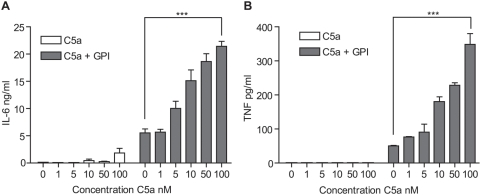
C5a potentiates pfGPI-induced inflammatory cytokines in a dose-dependent manner.Human PBMCs were stimulated with varying concentrations of recombinant human C5a (0, 1, 5, 10, 50, 100 nM) for 24 hours, with or without pfGPI. Culture supernatants were collected and assayed for IL-6 (A) and TNF (B) by ELISA. Data were analyzed by two-way ANOVA and demonstrate an interaction effect (C5a*pfGPI) for IL-6 (***p<0.0001) and for TNF (***p<0.0001). Data are presented as means±SEM of three independent experiments.